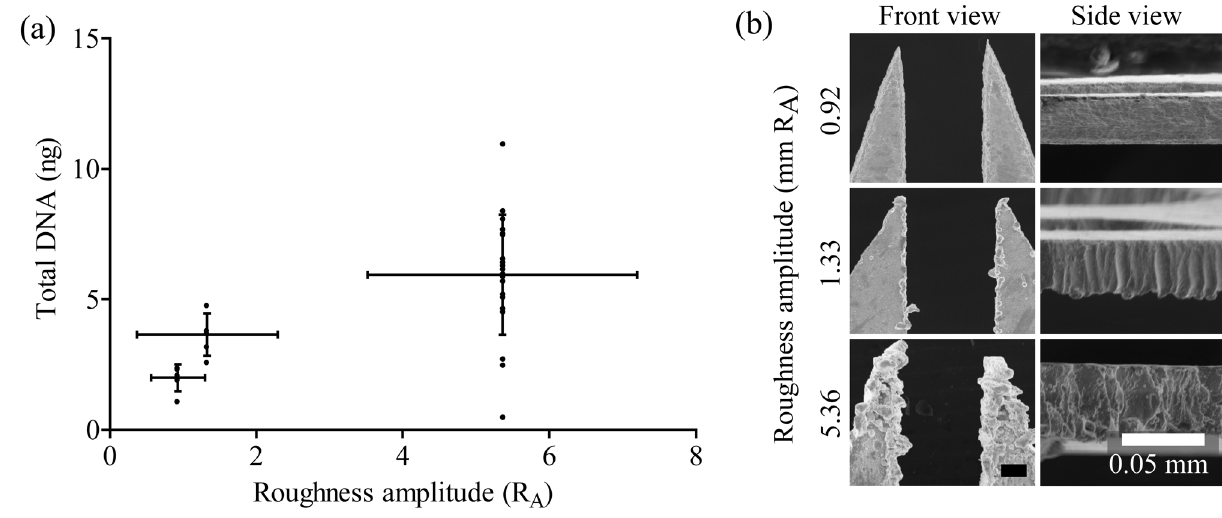
Figure 3. Microbiopsy roughness amplitude optimisation. Panel ( a ) shows that microbiopsy devices with higher roughness amplitude channels are capable of collecting more DNA. Panel ( b ) contains high resolution scanning electron microscopic images showing different channel widths and roughness of the microbiopsy